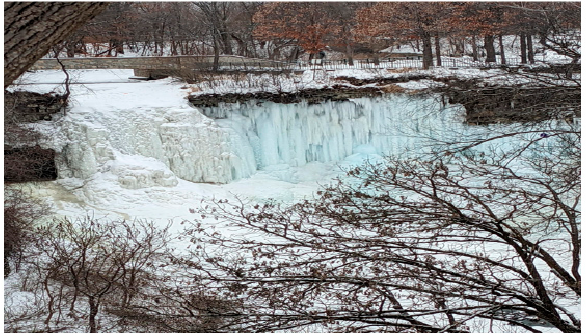
Figure 8. Minnehaha Falls in Minneapolis, Minnesota represented a place for quiet reflection.